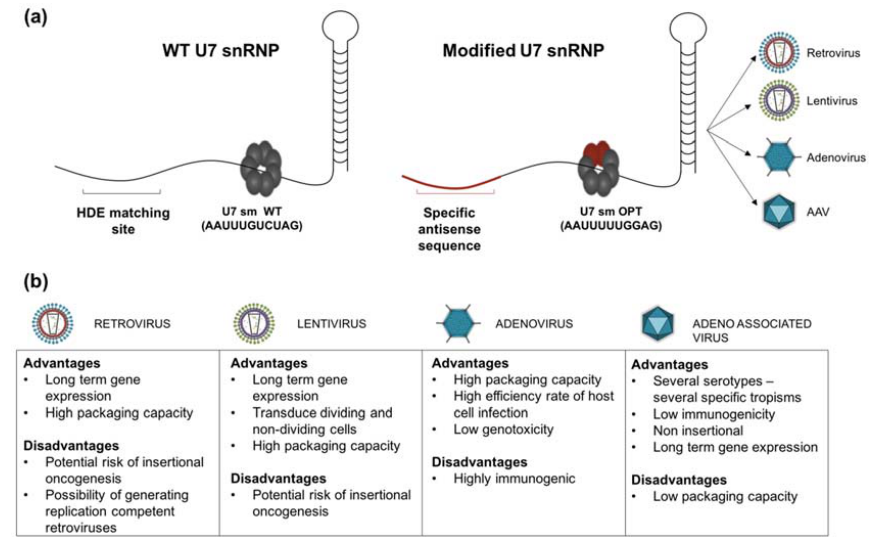
Figure 1. ( a ) Structure of U7 small nuclear ribonucleoproteins (snRNPs). snRNPs are the complexes formed by specific snRNA and the protein complex called Sm core, composed of seven Sm or Lsm (Sm ‐ like) proteins encircled around the snRNA Sm binding site. The hairpin at the 3 ′ end plays